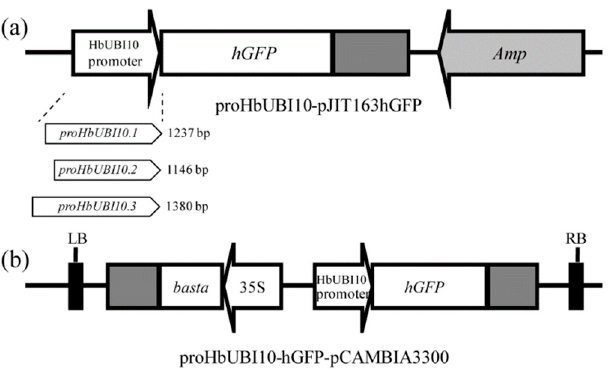
Figure 1. Schematic representation of the vectors used for Hevea transformation. ( a ) Transient expression vectors used for protoplasts transformation contain an GFP reporter gene driven by three Hevea polyubiquitin promoters, respectively. ( b ) T-DNA region of the binary vector used for Agrobacterium -mediated transformation of Hevea embryos.